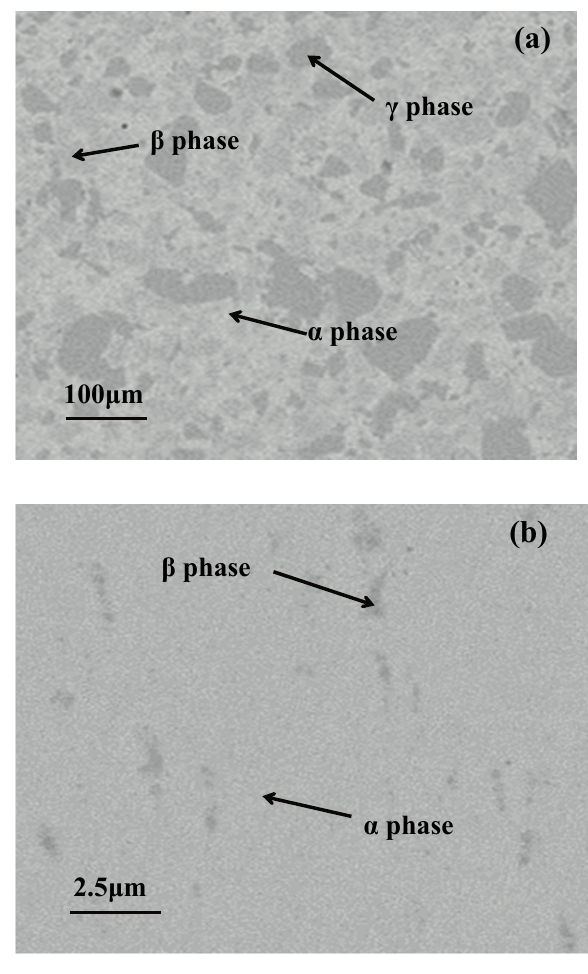
Figure 1. Microstructure (BEI) of PMFe-40Ni-15Cr and MAFe-40Ni-15Cr alloys: (a) PMFe-40Ni-15Cr and (b)